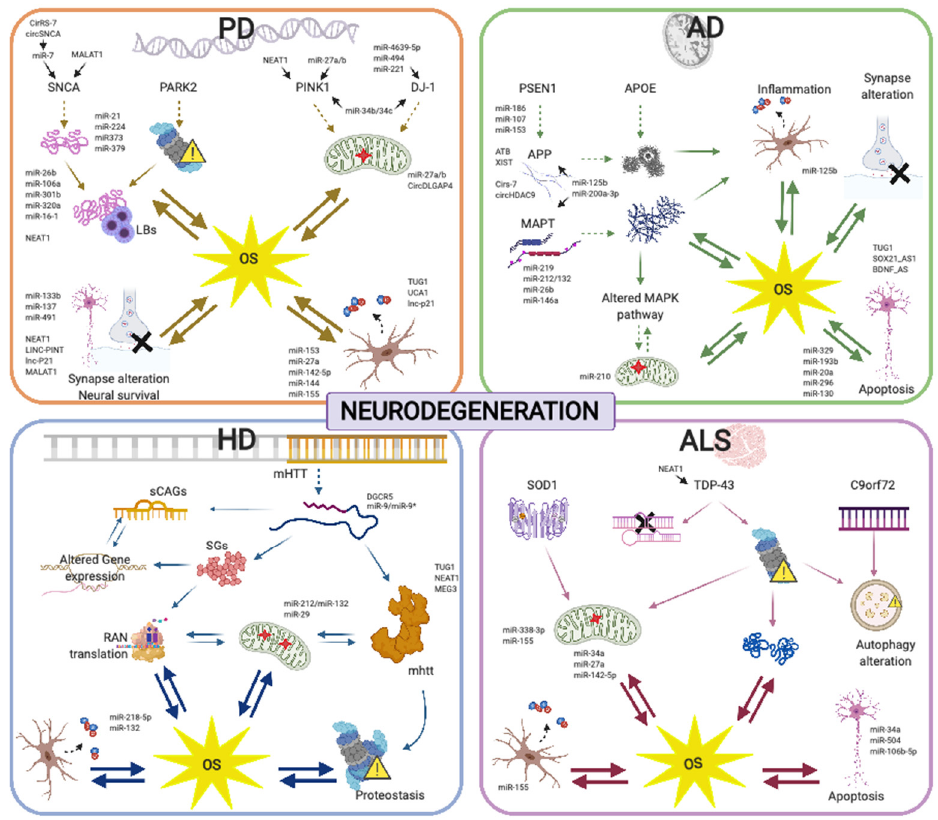
Figure 2. Regulatory ncRNAs are involved in oxidative stress (OS) management in diverse neurodegenerative diseases. Experimentally evidenced ncRNAs related to proteosomal and mitochondrial dysfunction, protein metabolism, reactive oxygen species (ROS) and OS generation and neural viability for Alzheimer’s disease (AD), Parkinson’s disease (PD), Huntington’s disease (HD) and amyotrophic lateral sclerosis (ALS) are shown.